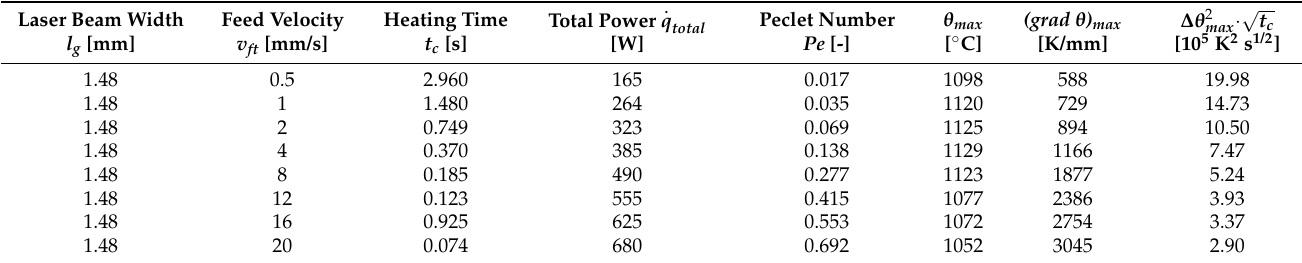
Table 2. Parameters applied for the simulation study and the resulting values for the considered descriptive values. The Peclet number is calculated with a mean thermal diffusivity κ of 10.7 mm 2 /s. The parameters are applied for the initial microstructures QT 30HRC and QT 47HRC .